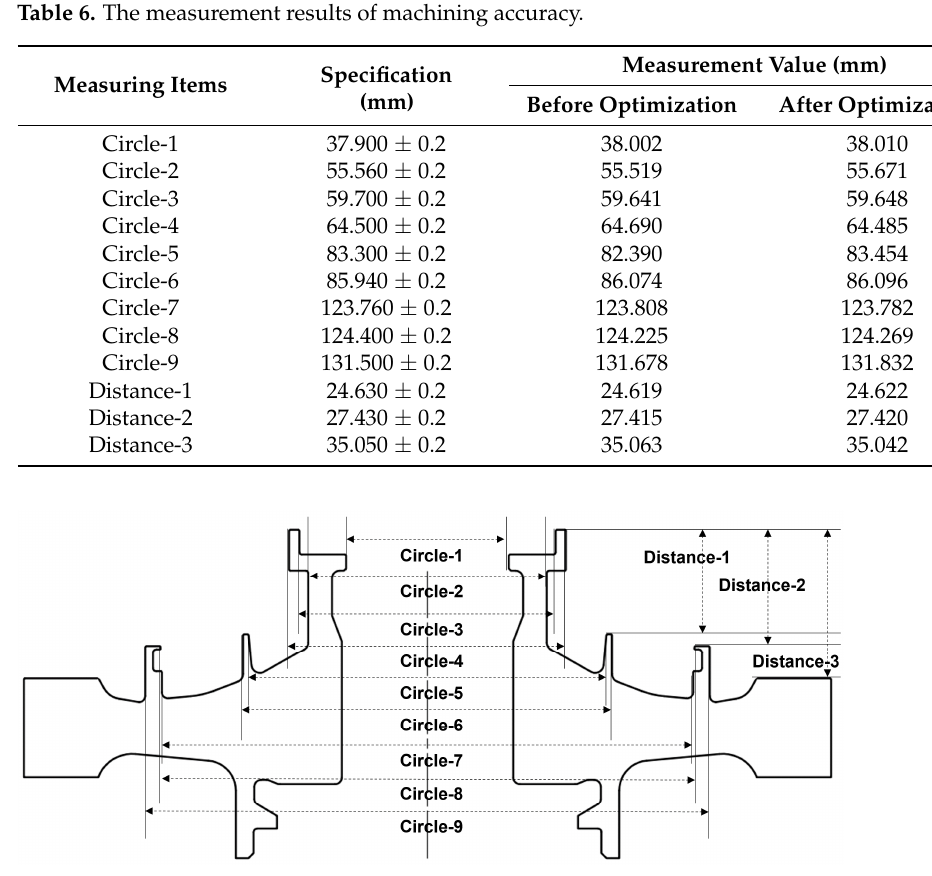
Figure 9. Measurement points.